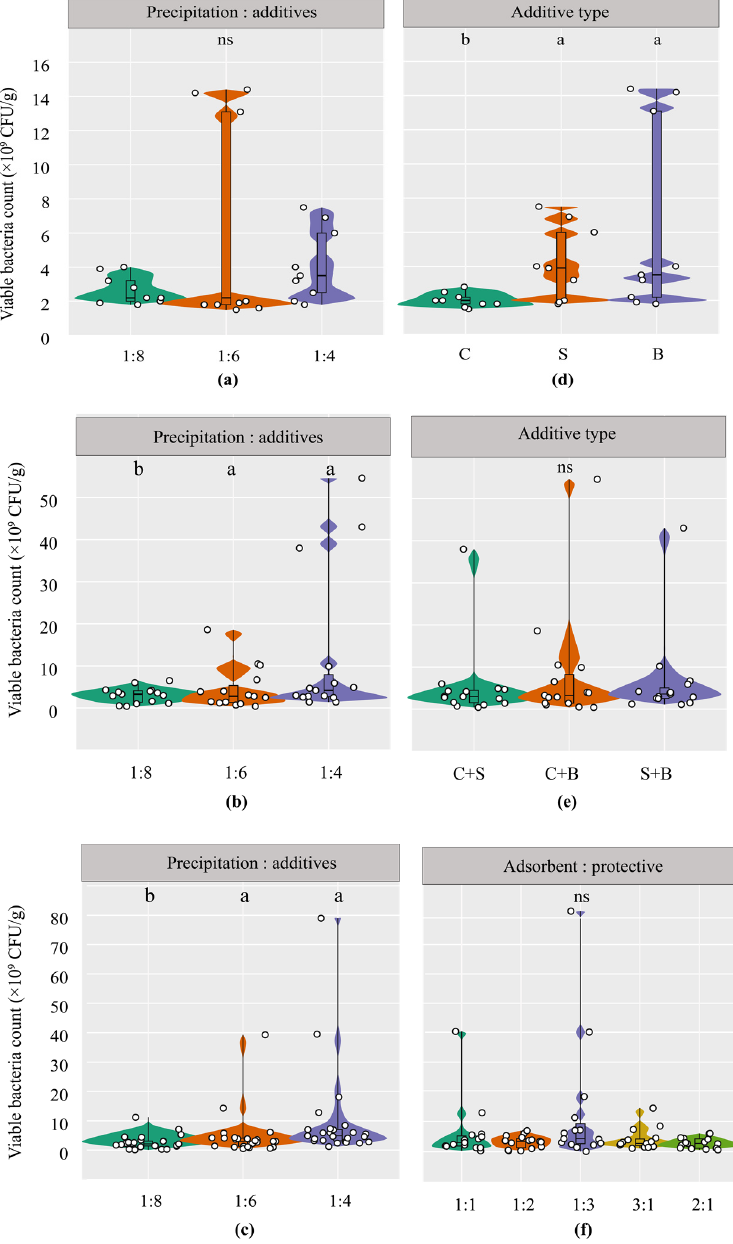
Figure 2. Viable bacterial count among the three ratios of precipitates to additives when ( a ) one, ( b ) two, and ( c ) three types of additives are used in the bacterial agent. ( d ) Viable bacterial count among the three additive groups, ( e ) three combination modes for the additives, and ( f ) five ratios of adsorbent to protective agents when combined with one, two, and three types of additives, respectively. C: corn stalk husk powder; S: starch; B: bran. ns: no significant difference. Significant differences at p < 0.05 are indicated by lowercase letters.